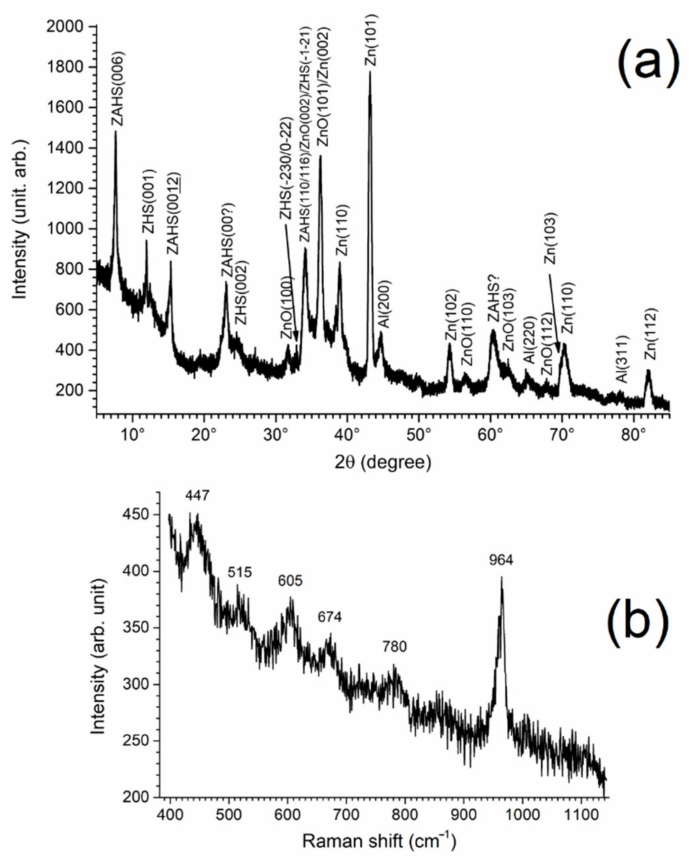
Figure 11. XRD ( a ) and µ -RS ( b ) analysis of a Zn-15wt.%Al coating surface after the 6-month galvanic corrosion experiment. ZHS(hkl) = zinc hydroxysulfate, ZAHS(hkl) = zinc aluminum hydroxysulfate, Al(hkl) = aluminum, Zn(hkl) = zinc, and ZnO(hkl) = zincite, with the corresponding Miller